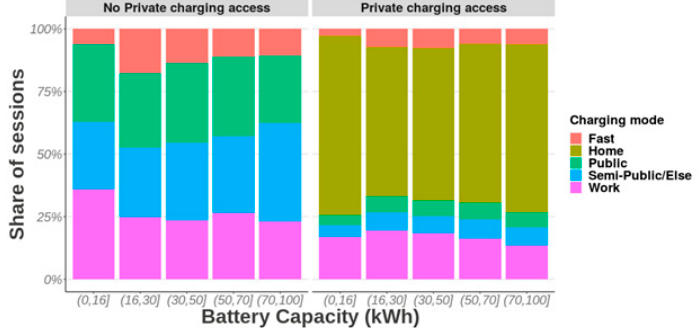
displayed for different battery size capacities and the availability of private charging.